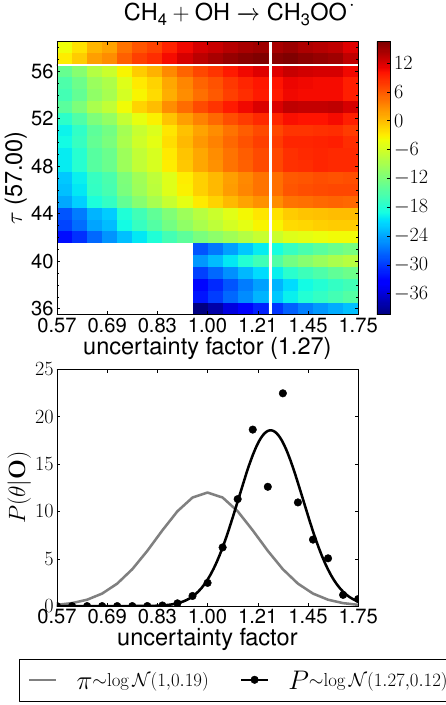
q q → H Fig. A8. Same as Fig. A1 for the CH 4 +OH +HO 2 O+O 2 reac- 2 Fig. A8. Same as Fig. A1 for the CH 4 +OH reaction.